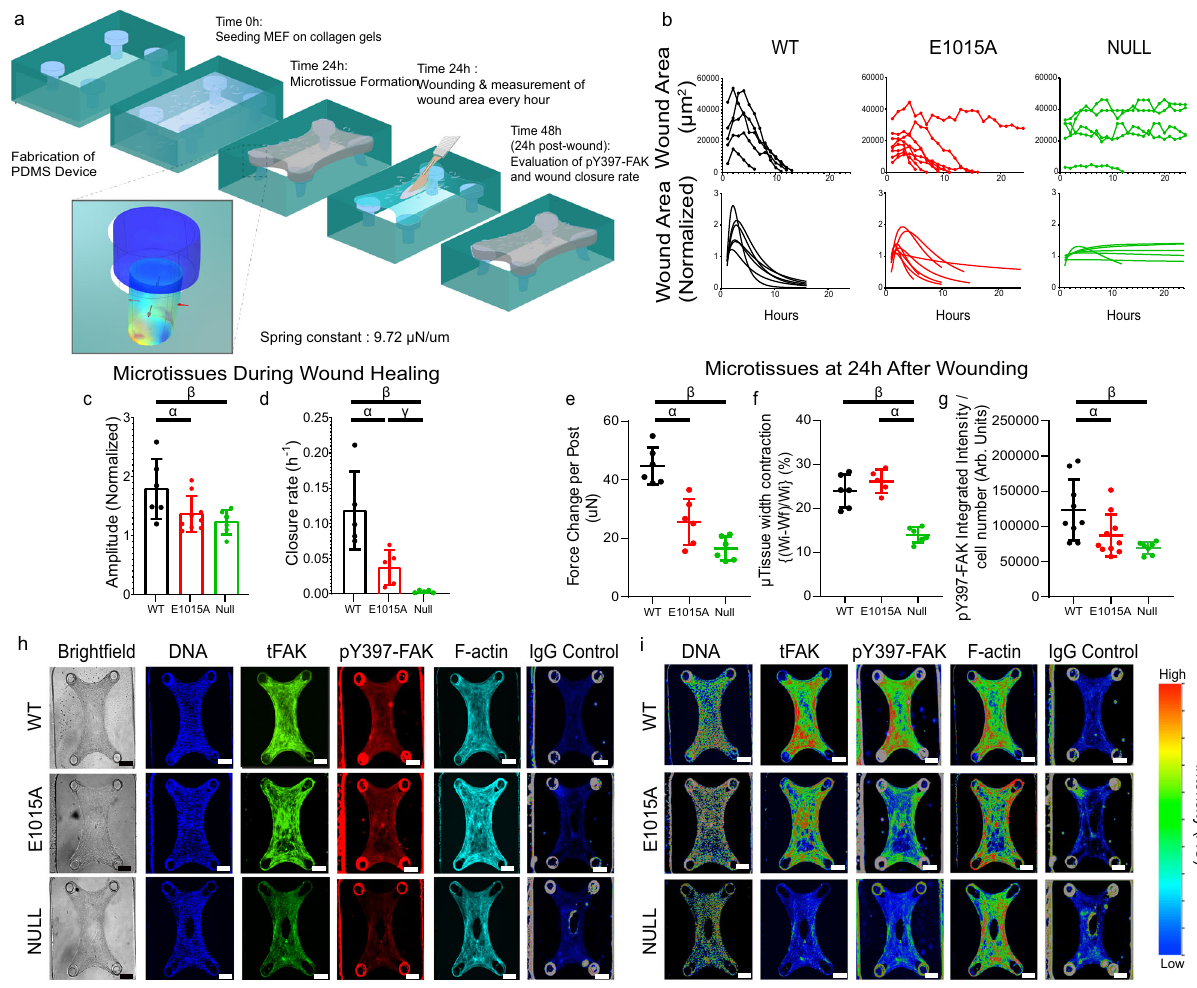
Fig. 5 FAK-talin binding regulates wound closure of 3D microtissues. a Schematic of microtissue assembly and wound closure assay. Collagen gels containing FAK-null cells expressing FAK constructs compact and form microtissue. At 24 h post-seeding, the wound is created using a microdissection knife, and wound closure is monitored over time. b Wound area (top) and log-normal curve fi t for wound area normalized to the initial area (bottom) as a function of time for individual microtissues. c Amplitude (mean ± SD) of normalized wound area pro fi le. Kruskal-Wallis test P = 0.0351, α : P = 0.0440, β : P = 0.0176, n = 6 microtissues for WT and null and 9 microtissues for E1015A. d Closure rate (mean ± SD) of normalized wound area pro fi le. ANOVA with Welch ’ s correction P = 0.0064, α : P = 0.0213, β : P = 0.0088, γ : P = 0.0289, n = 5 microtissues for each condition. e , Net force difference (mean ± SD) between pre-wounding and 24 h post-wounding. Kruskal-Wallis test P < 0.0001, α : P = 0.0266, β : P = 0.0003, n = 6 microtissues for each condition. f Microtissue width contraction (mean ± SD). Kruskal-Wallis test P = 0.0002, α : P = 0.0015, β : P = 0.0101, n = 6 microtissues for each condition. g pY397- FAK integrated intensity (mean ± SD) at 24 h post-wounding. Kruskal-Wallis test P = 0.0056, α : P = 0.0232, β : P = 0.0020, n = 9, 10, and 7 microtissues for WT, E1015A, and null, respectively. h Bright fi eld and fl uorescence (DNA, tFAK, pY397-FAK, F-Actin, IgG control) images for microtissues at 24 h post- wounding. i Intensity heatmaps (DNA, tFAK, pY397-FAK, F-Actin, IgG control) for microtissues. The images in h – e are representative of images from n = 9, 10, and 7 microtissues for respective groups. Scale bar 200 µ